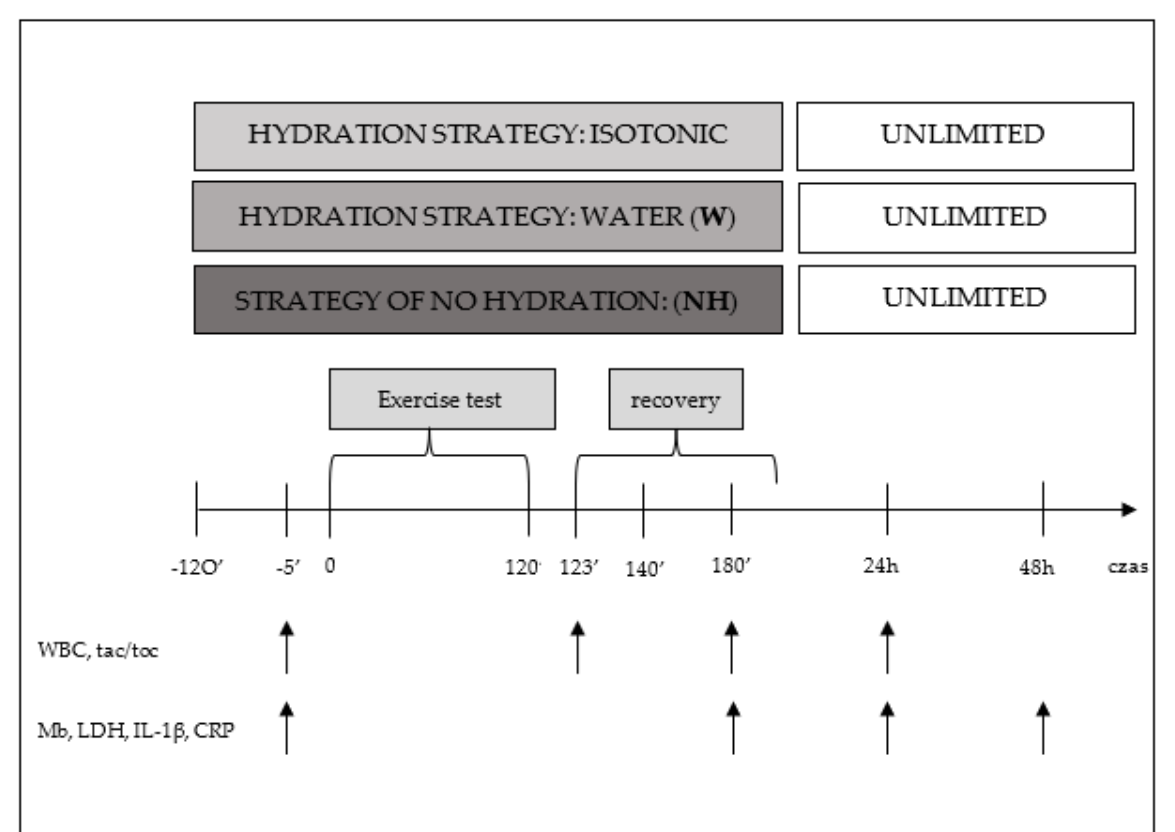
Figure 2. Diagram of one series of tests during the main part of the study, including measurement points WBC — white blood cells, tac/toc-pro-oxidant/antioxidant status, LDH — lactate dehydrogen- points WBC—white blood cells, tac/toc-pro-oxidant/antioxidant status, LDH—lactate dehydroge- ase, Mb — myoglobin, IL −1β—interleukin 1β, CRP -C — reactive protein. nase, Mb—myoglobin, IL − 1 β —interleukin 1 β , CRP-C—reactive